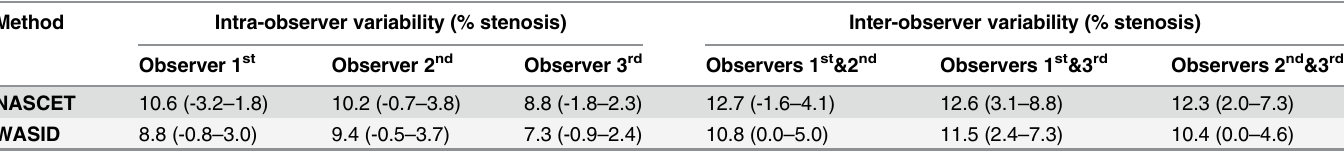
Table 3. The mean absolute difference and 95% confidence intervals of the mean difference of intra- and inter-observer variabilities in the evalua- tion of MCA stenosis.